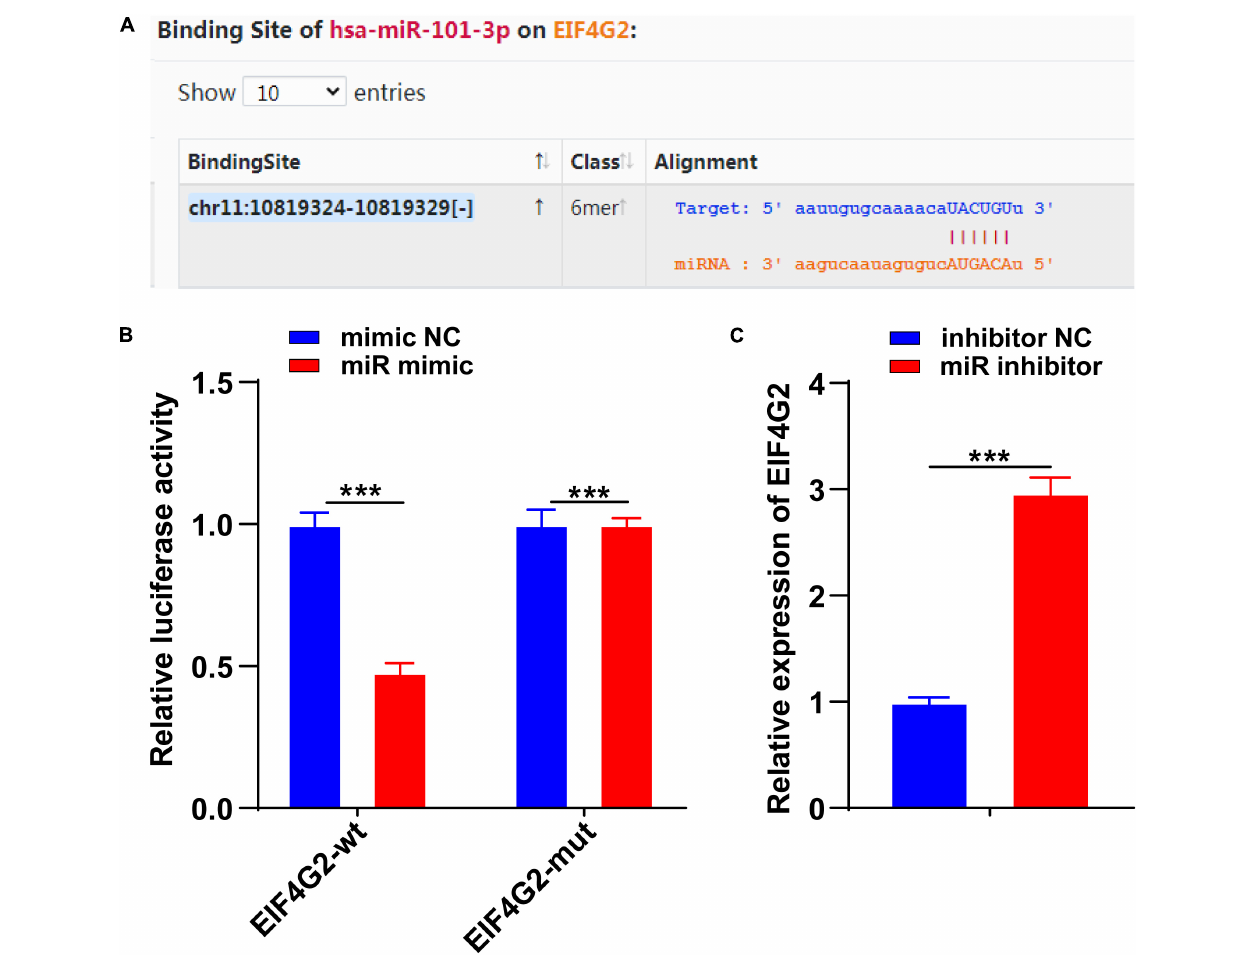
FIGURE 4 | miR-101-3p targeted EIF4G2. (A) The binding site between miR-101-3p and EIF4G2 was predicted by using the Starbase database; (B) the binding relationship between miR-101-3p and EIF4G2 was verified using dual-luciferase reporter gene assay; and (C) expressions of EIF4G2 in miR-101-3p inhibitor-transfected NPCs were detected using the RT-qPCR. The cell experiments were repeated three times independently. Data are presented as mean ± SD. Data were analyzed using the independent sample t -test, *** p <